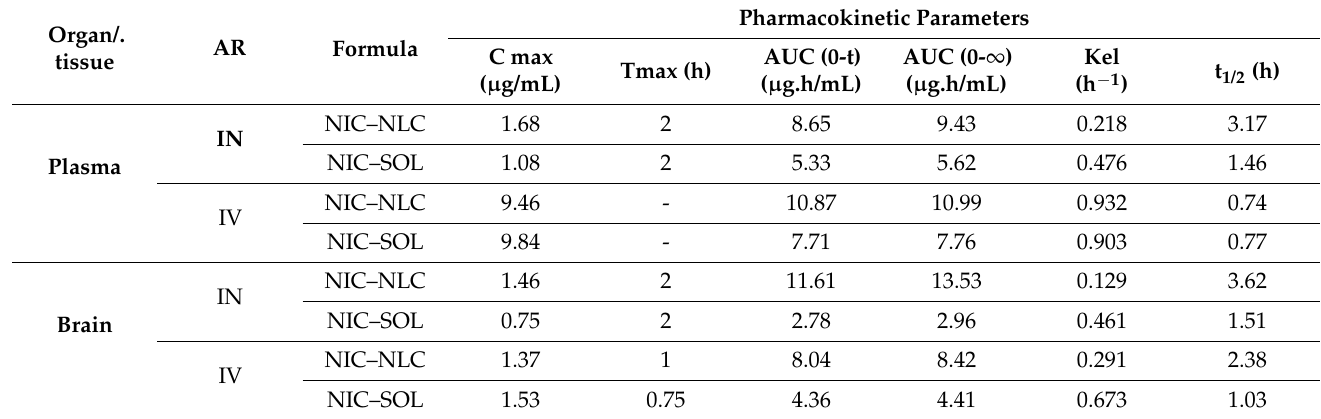
Table 6. Pharmacokinetic parameters of NIC in plasma and brain following IN and IV administration of the optimized NIC–NLC formula and NIC–SOL. Organ/. tissue